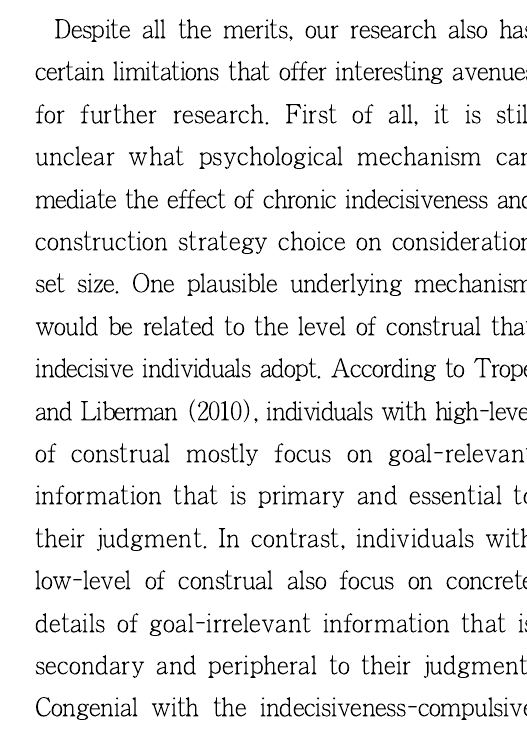
The Effect of Inclusion versus Exclusion on Consideration Set Size: The Moderating Role of Chronic Indecisiveness